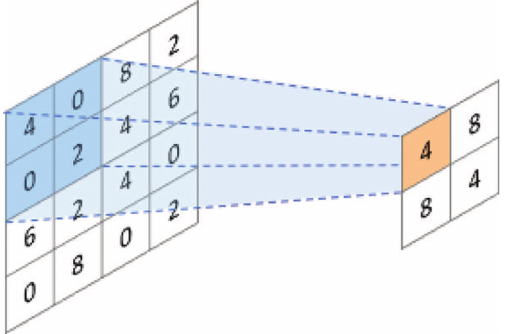
Figure 2: Pooling